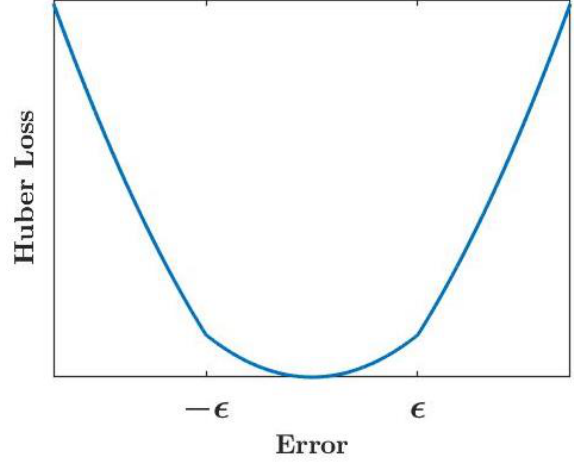
Figure 2. The transfer function of Huber loss. (cid:101) is the transition